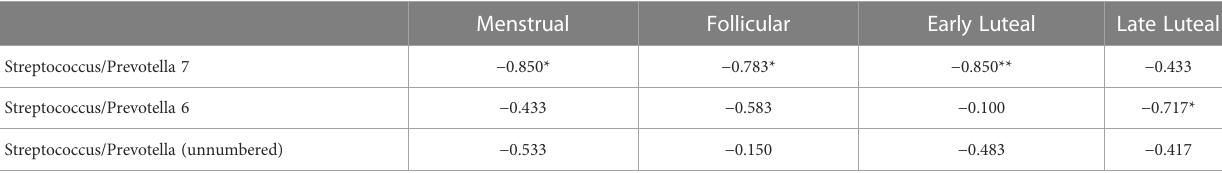
TABLE 1 Correlation of the abundance ratios of bacterial genera in menstrual cycles. Menstrual Follicular Early Luteal Late Luteal − 0.850* −